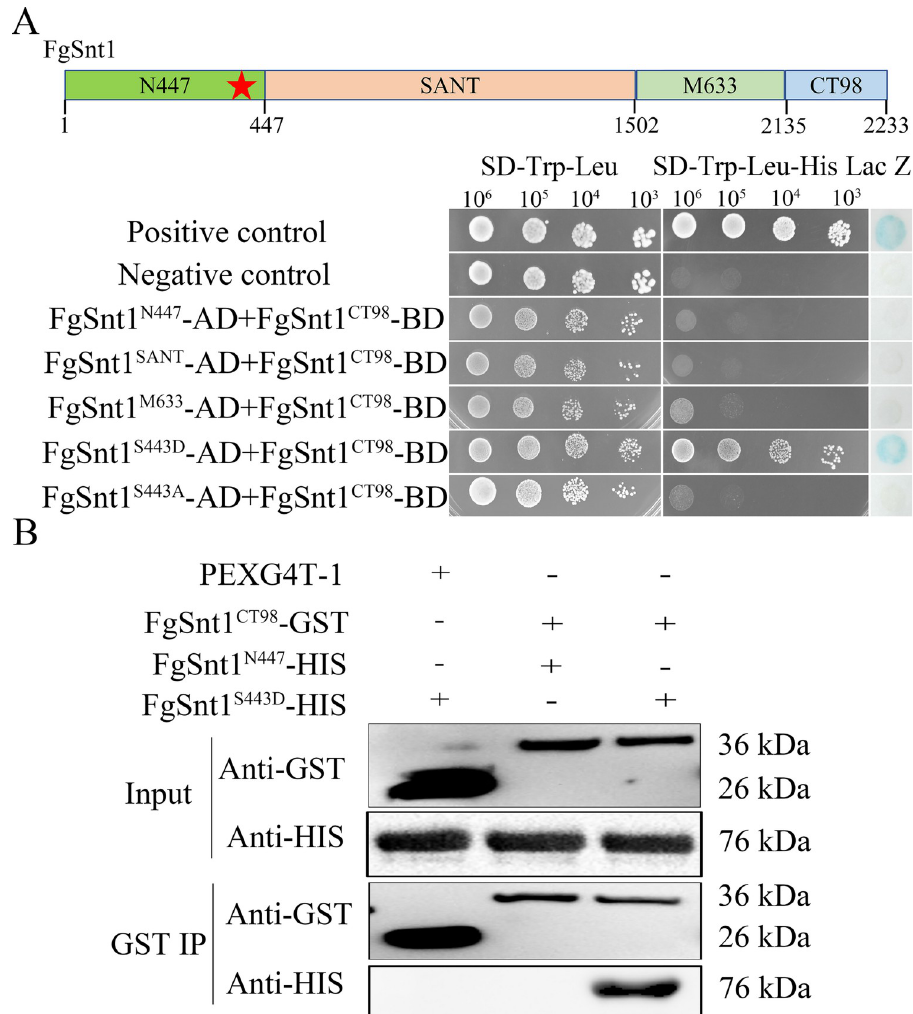
Fig 11. Assays for intramolecular interactions in FgSnt1 and the effect of S443D mutation. (A). Yeast two-hybrid assays for the intramolecular interactions in FgSnt1. Yeast cells expressing the marked bait (BD) and prey (AD) constructs were assayed for growth on SD-Trp-Leu (left), SD-Trp-Leu-His plates (middle), and LacZ activities (right). N447, SANT, M633, and CT98 are fragments containing residues 1–447, 448–1502 (SANT domains), 1503–2136, and 2135–2233 of FgSnt1, respectively. FgSnt1 S443D and FgSnt1 S443A have the S443D and S443A mutations in N447. The positive and negative controls are from the Matchmaker kit. (B). IP assays for the interaction of FgSnt1 CT98 with FgSnt1 N447 and FgSnt1 S443D . Blots of the mixtures of marked recombinant proteins (input) and proteins eluted from eluted from anti-GST beads (GST IP) were detected with the anti-GST and anti-HIS antibodies. Proteins from E . coli cells expressing the empty GST vector pGEX4T-1 were used as the